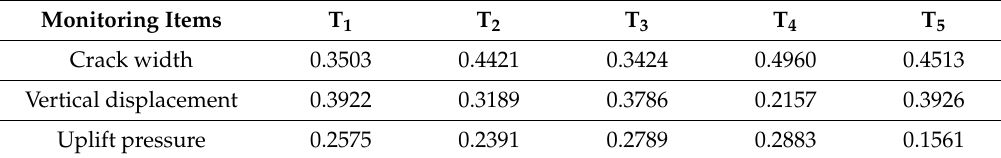
Table 9. The weight variation of monitoring items for the dam section #13.